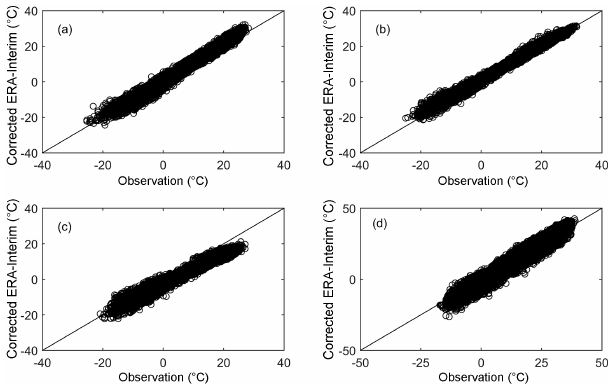
Figure 5. Scatter plots of observation and corrected ERA-Interim temperature data for (a) station no. 10, (b) station no. 24, (c) station no. 9 and (d) station no. 15. The corresponding RMSE can be found in Table 3.